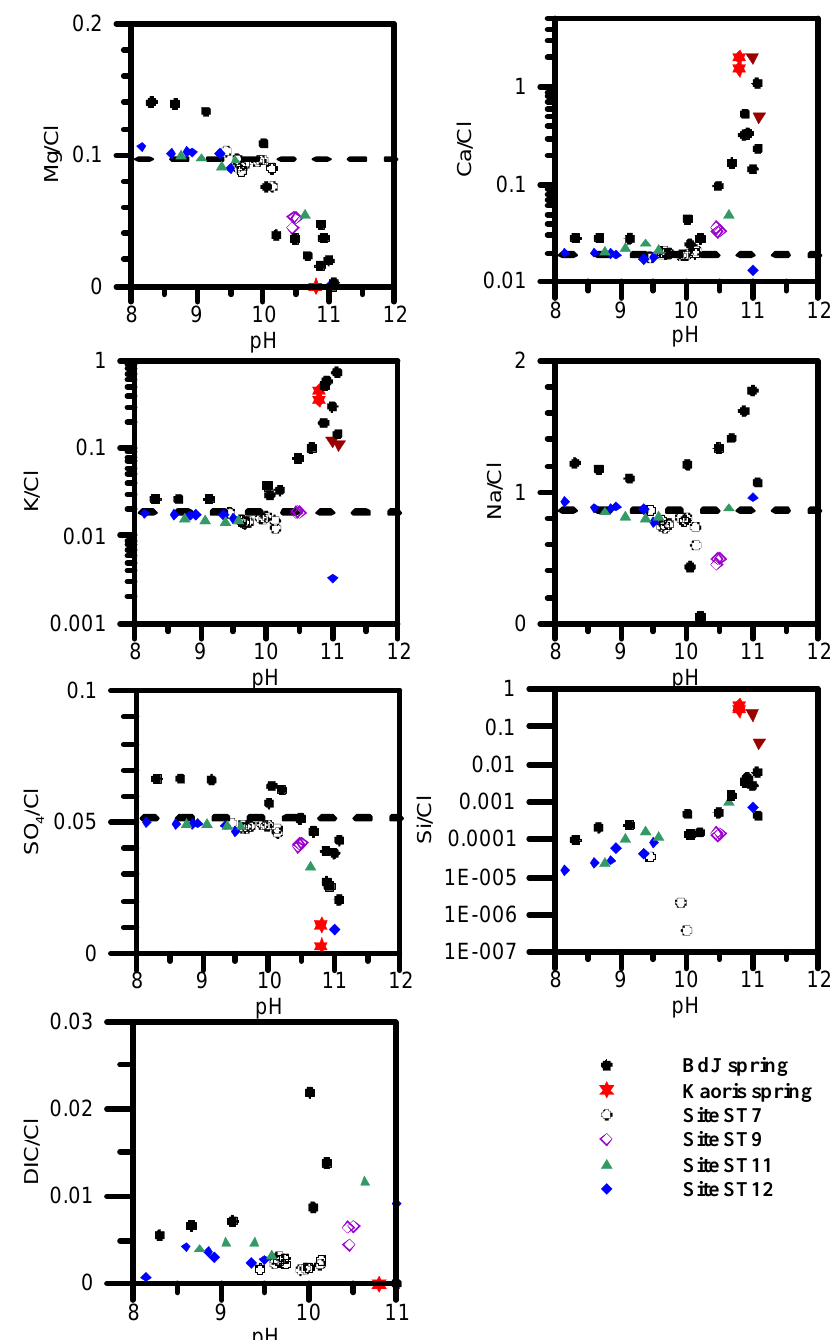
Figure 7. Chloride-normalized element concentrations versus pH. Same symbols as for Fig. 5. The dashed line represents the value for standard seawater (Millero,